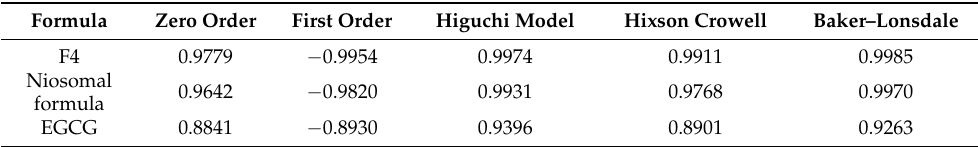
Table 6. The calculated correlation coefficients for the ex vivo permeation of F4, the niosomal formula, and EGCG employing different kinetic